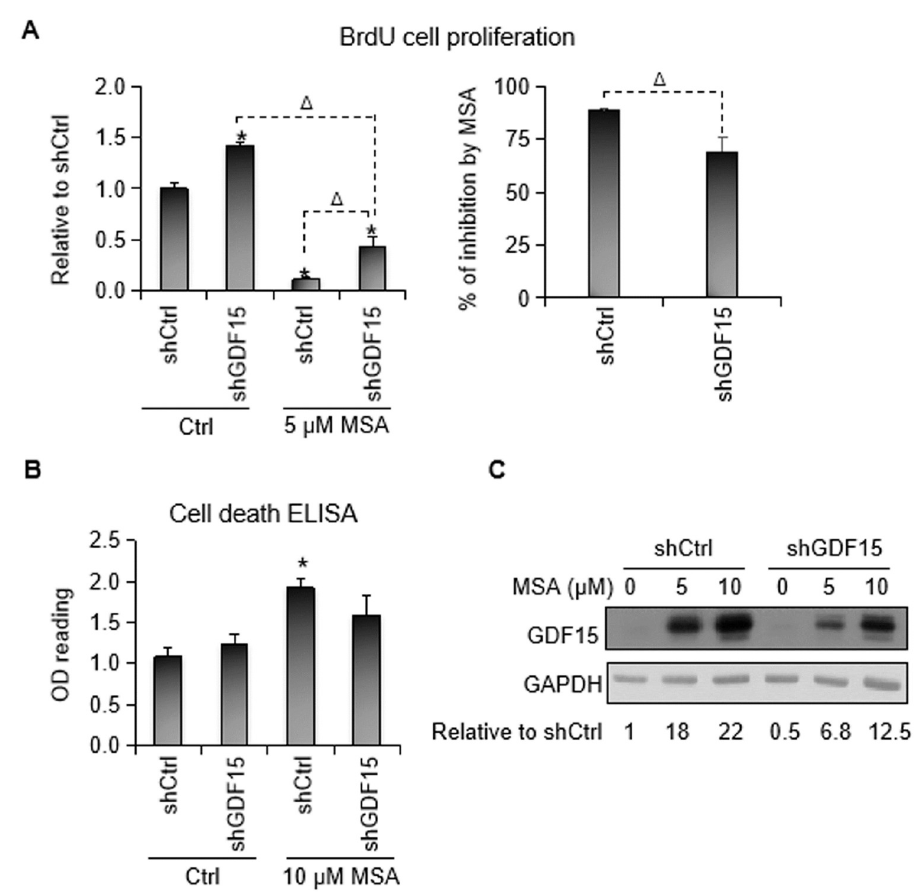
BrdU ELISA, Cell Death ELISA, and Western blot analysis were conducted at 24 h post-MSA treatment. A . BrdU cell proliferation ELISA showing GDF15 knockdown promoting cell proliferation and attenuating the inhibitory effect of MSA on cell proliferation in LNCaP cells. Data are presented as relative to the untreated shCtrl group (left panel) or percentage of inhibition by MSA in control and GDF15 knockdown cells (right panel). Δ , P < 0.05 using Student’s t test. B . Cell death ELISA showing GDF15 attenuating MSA induction of apoptosis in LNCaP cells. Data are presented as mean OD reading at 405 nm subtracted by the OD reading of incubation buffer for individual groups. C . Western blotting showing the efficacy of GDF15 knockdown. The numbers below the blots denote relative normalized intensities of the GDF15 protein bands compared to the untreated shCtrl value of 1. Treatment duration, 24 h. Bars, SEM. � , P < 0.05 from control using Student’s t